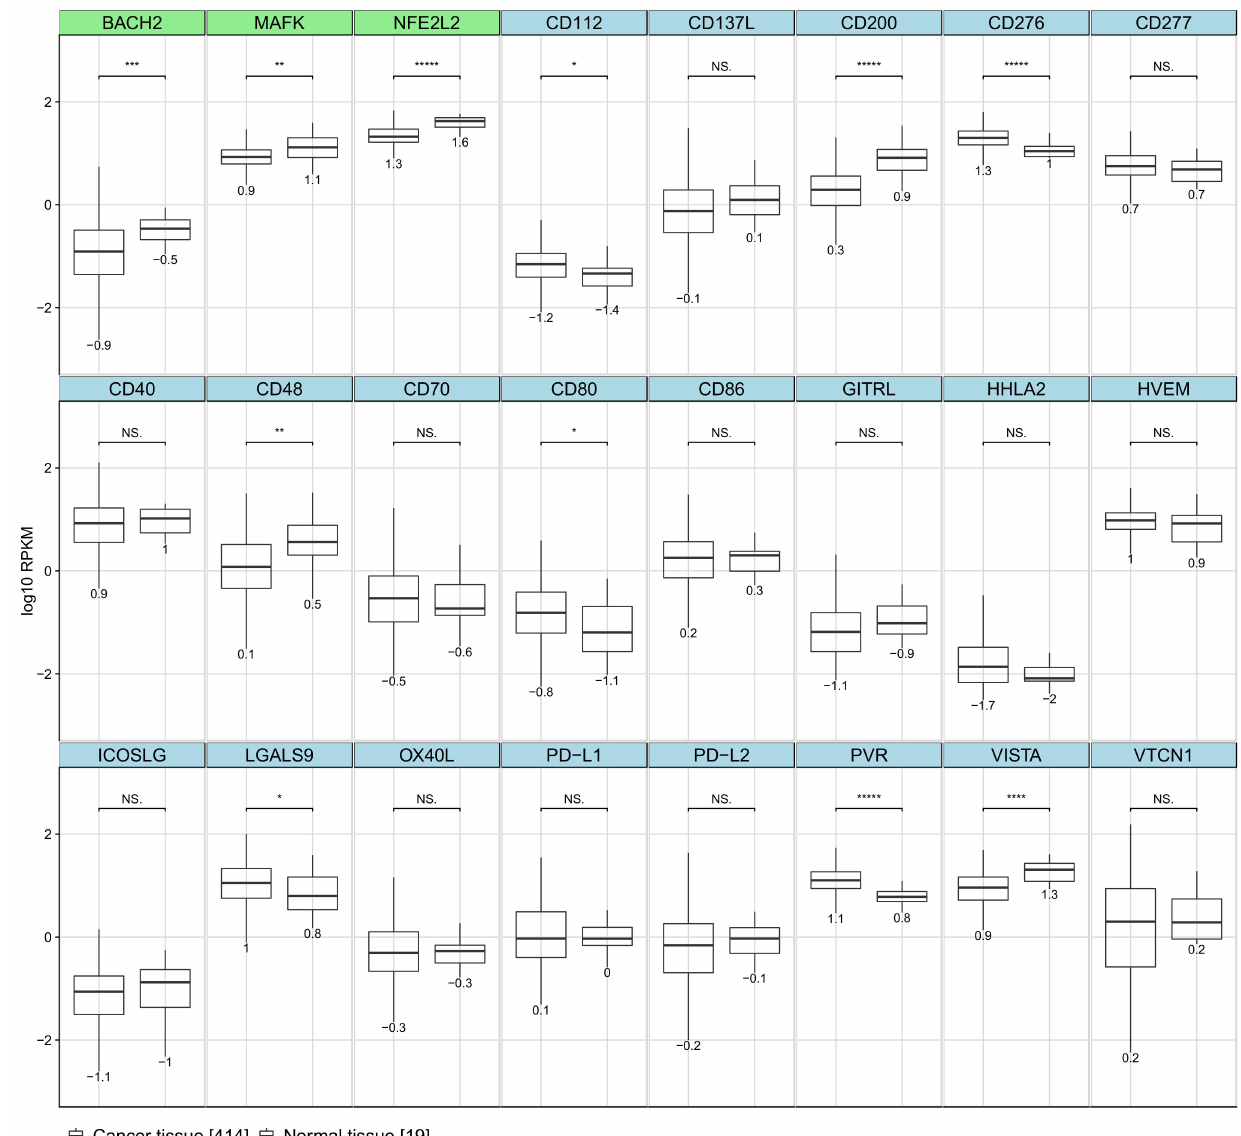
Figure 9. Comparison of gene expression values in cancer vs. normal tissue. Visualised values represent fragments per million reads per kilobase of transcript (FPKM) obtained from TCGA. Violin plots show the distribution of expression values, with imposed boxplots visualising box statistics. A value below the violin plot denotes the median of the sample. The stars above each group indicate the significance level ( p -value) derived from Mann–Whitney (Wilcoxon) U test. p -value mapping go as follows: ***** represents a p -value below 0.00001, **** represents a p -value below 0.0001, *** represents a p -value below 0.001, ** represents a p -value below 0.01 and * represents a p -value below 0.1; “NS.” denotes not